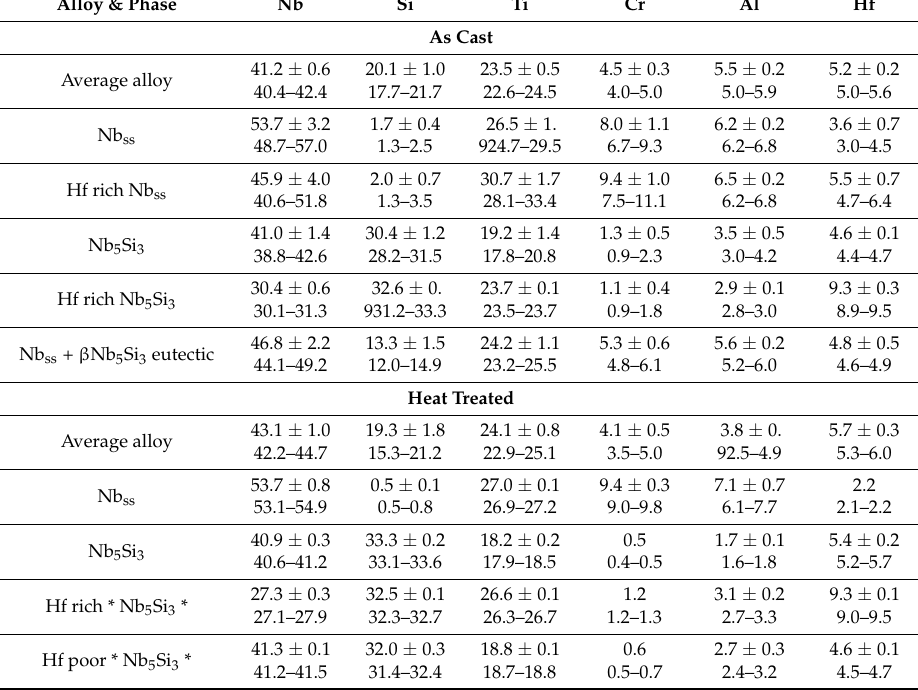
Table 2. EPMA data (at.%) for the as cast and heat treated alloy Nb-24Ti-18Si-5Al-5Cr-5Hf (average value, standard deviation, minimum and maximum analysis